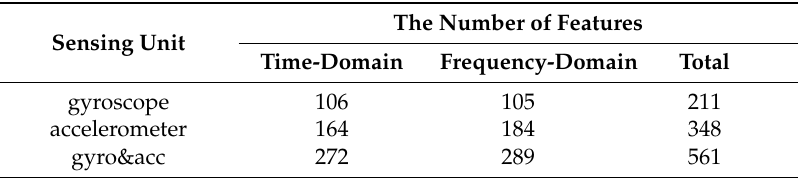
Table 3. Experimental dataset description.